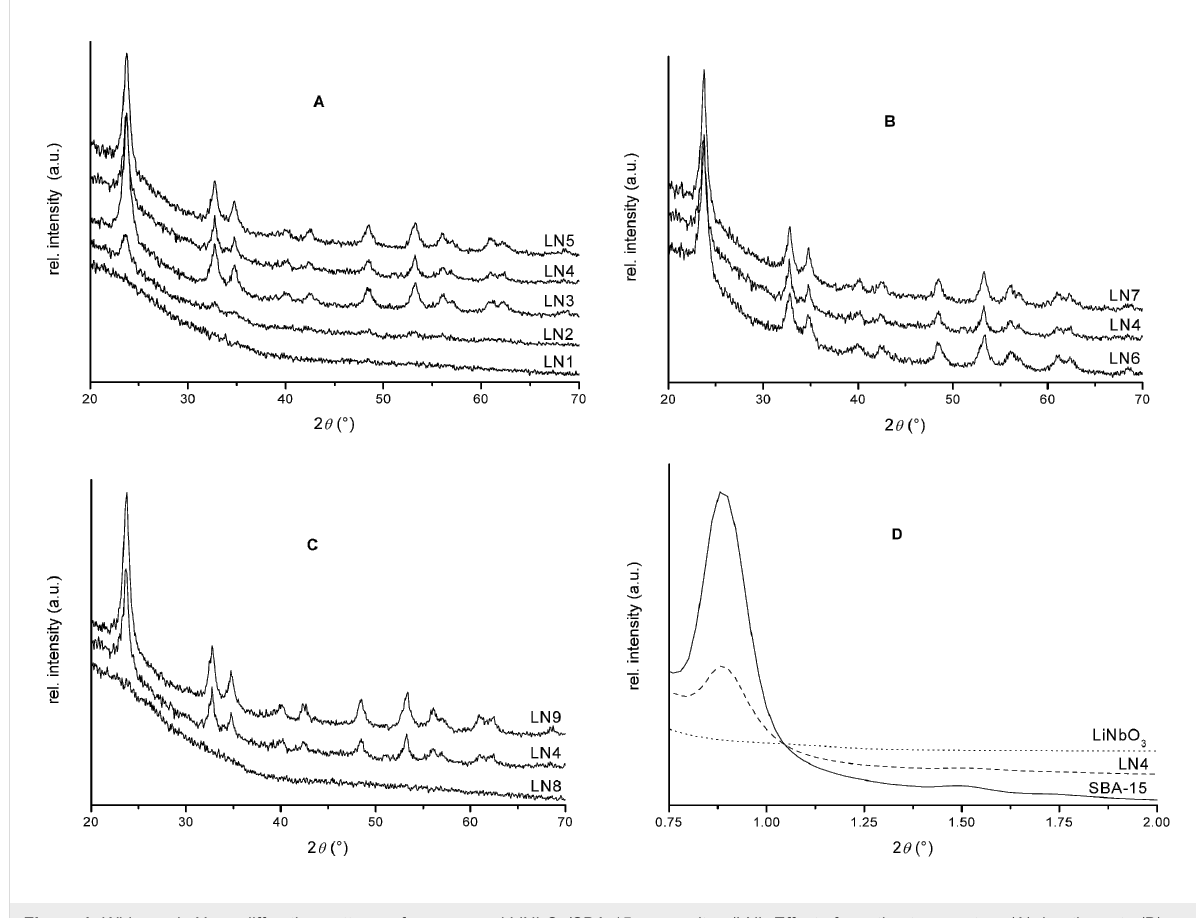
Figure 1: Wide-angle X-ray diffraction patterns of as-prepared LiNbO 3 /SBA-15 composites (LN). Effect of reaction temperature (A), heating rate (B), and reaction time (C). Small-angle X-ray diffraction patterns of SBA-15, composite and isolated nanoparticles (D). (For details of the experimental conditions for each sample, see Experimental